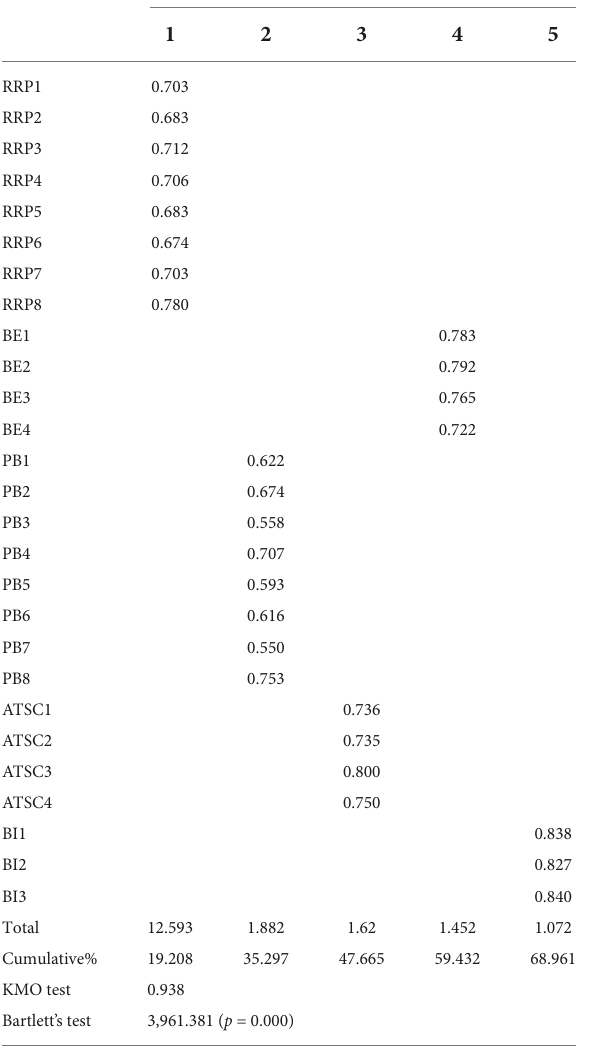
TABLE 4 Validity analysis results for each study variable.